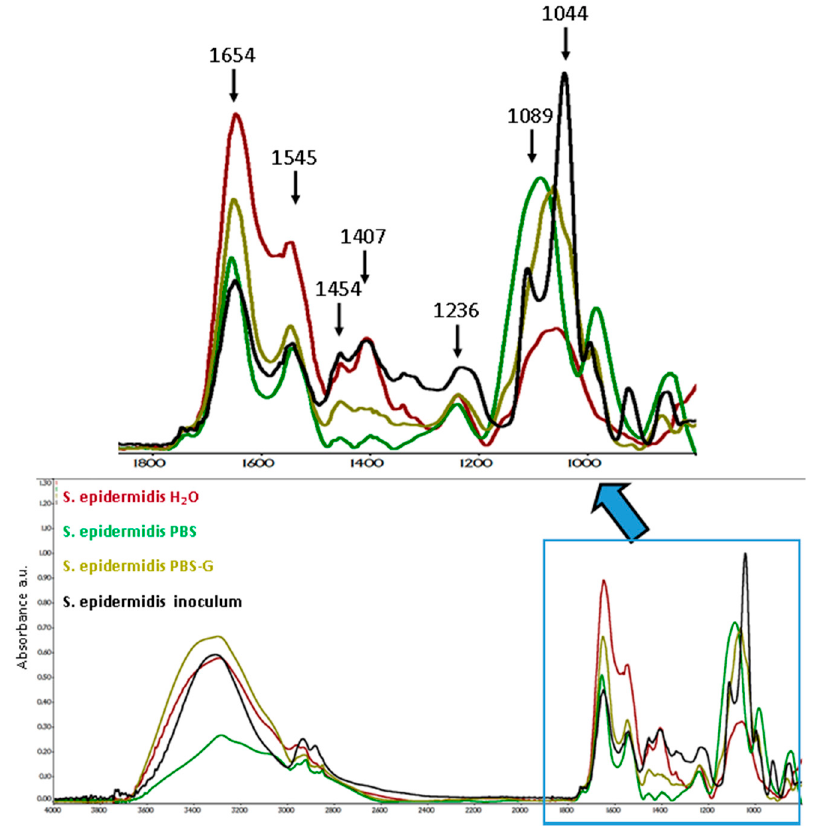
Figure 5. FTIR spectra of S. epidermidis after 180 min in H 2 O, phosphate buffered solution (PBS), and PBS with glucose (PBS-G) compared with inoculum.